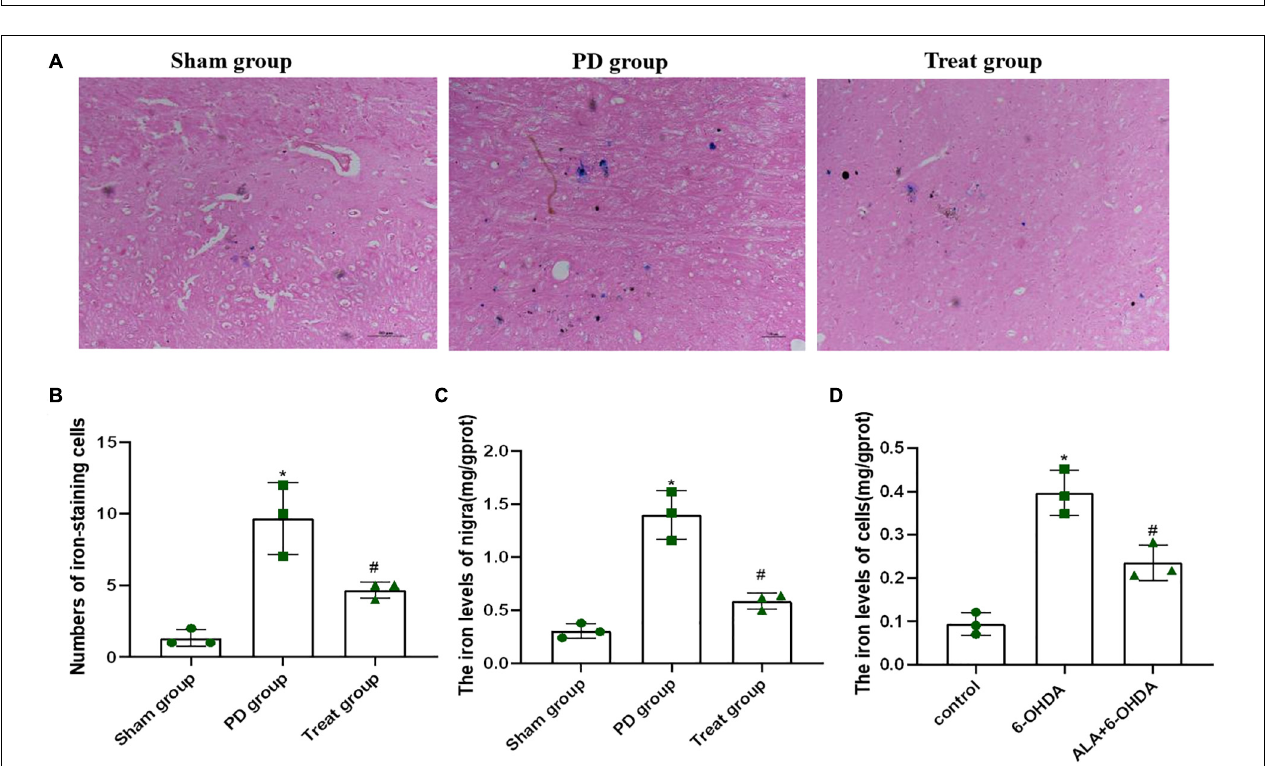
FIGURE 4 | ALA attenuates 6-OHDA-induced increase in ROS levels of PC12 cells. (A) Corresponding DCF-fluorescent picture induced by 200 µ M 6-OHDA and/or 10 µ M ALA in PC12 cells. The brightened dot represents the fluorescence of ROS. (B) DCF fluorescence intensity induced by 200 µ M 6-OHDA and/or 10 µ M ALA in PC12 cells. Data were expressed as the means ± SD analyzed by one-way ANOVA ( n = 3). Statistical significance: * P < 0.01 vs. control; # P < 0.01 vs. 6-OHDA group.